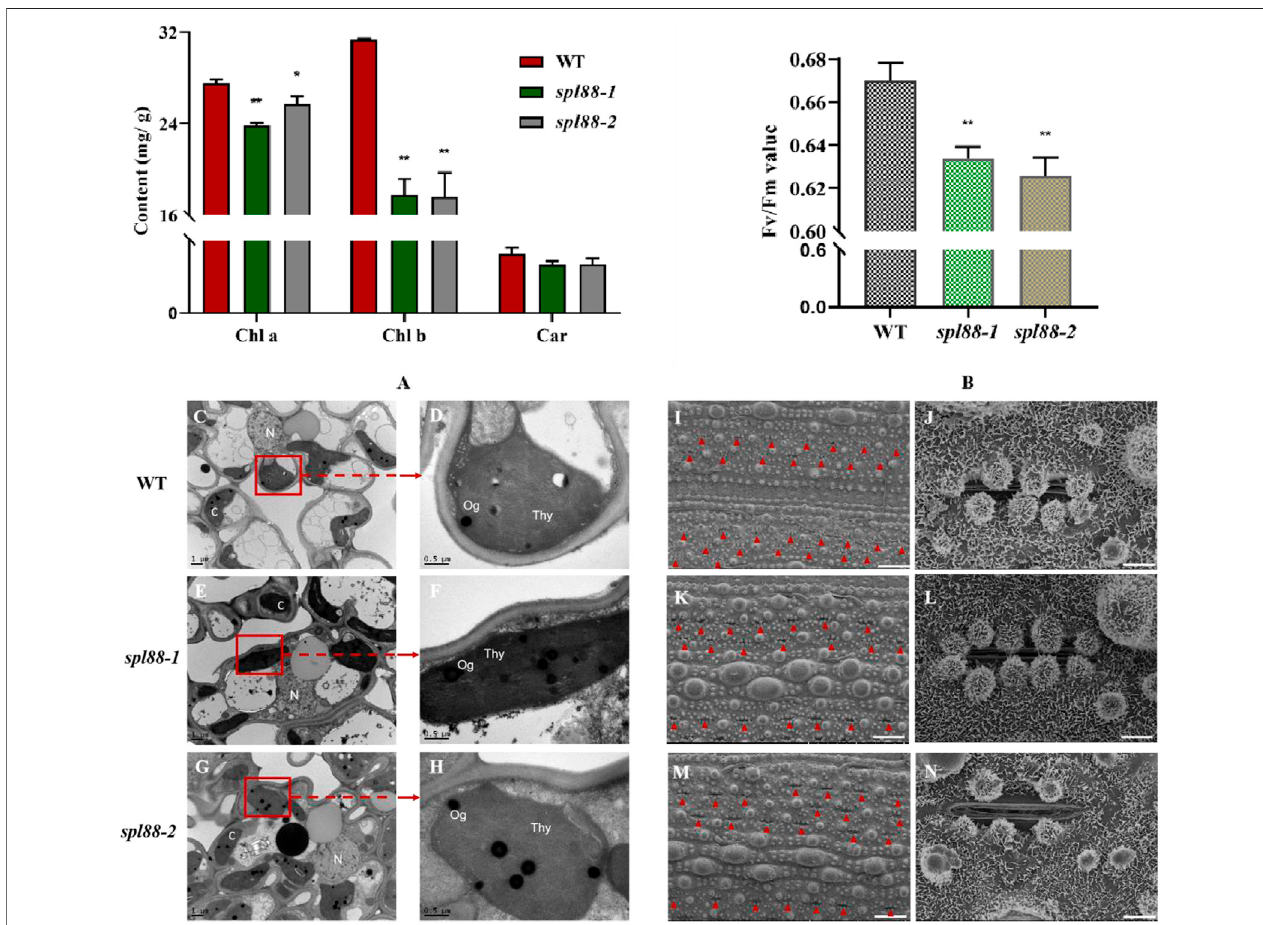
FIGURE3| Chloroplastdevelopment,maximumphotosyntheticrate,andtheobservationofmesophyllcellelectronmicroscopeinwild-typeandmutantplants. (A) Chlorophyll content in fl ag leaves of wild-type and mutant plants. (B) Maximum photosynthetic rate of wild-type and mutant plants. (C – H ) Ultrastructural observation of chloroplast of wild type and mutant plants; (N) : nucleus; Thy: chloroplast; Og: osmium granules; Bar = 1 μ m. (I – N) : observation of stomatal pore diameter of wild-type andmutantplantleaves;I, (K,M) :Bar=300 μ m; (J,L,N) :Bar=30 μ m*indicatessigni fi canceat p ≤ 0.05byStudent ’ s t -test;**indicatessigni fi canceat p ≤ 0.01by Student ’ s t